Question: Does the figure show an increasing or a decreasing trend?
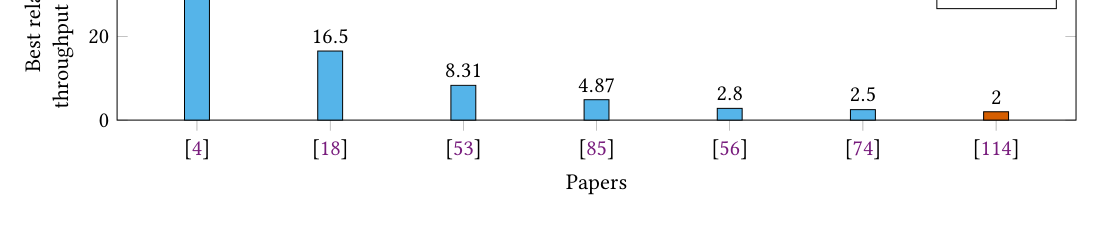
Answer: increasing